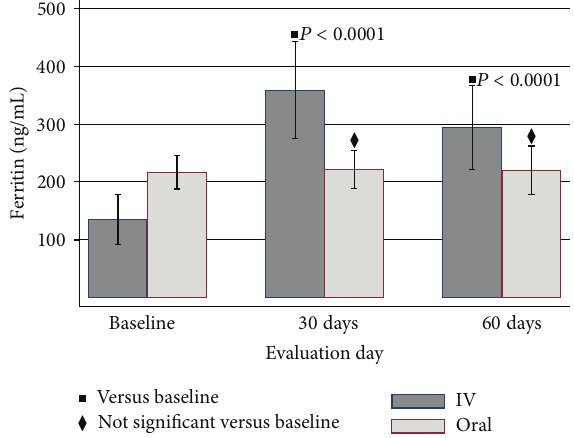
Figure 4: Mean ferritin ± SD by treatment group over duration of study. 𝑃 values compare 30 and 60 days to baseline values for the IV group.